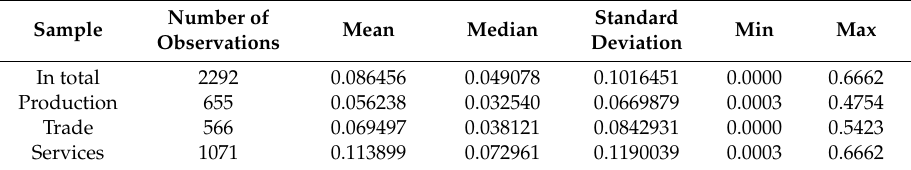
Table 1. Sample characteristics: Liquidity constraint (cash and cash equivalents to total assets).